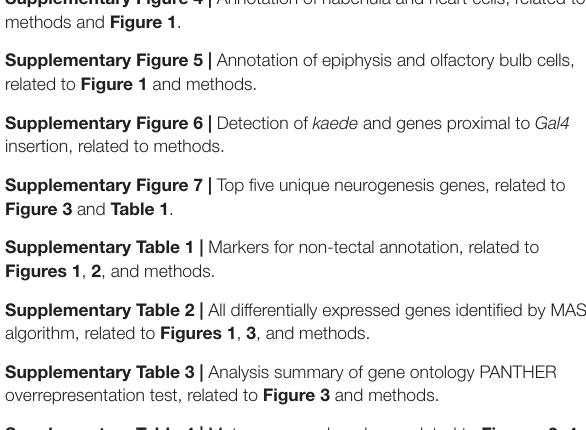
Supplementary Figure 1 | Sorting of kaede + cells for single-cell RNA sequencing, related to methods. Supplementary Figure 2 | Quality control for cell cycle regression, related to methods. Supplementary Figure 3 | Quality control check for batch effect, related to methods. Supplementary Figure 4 | Annotation of habenula and heart cells, related to methods and Figure 1 . Supplementary Figure 5 | Annotation of epiphysis and olfactory bulb cells, related to Figure 1 and methods. Supplementary Figure 6 | Detection of kaede and genes proximal to Gal4 insertion, related to methods. Supplementary Figure 7 | Top five unique neurogenesis genes, related to Figure 3 and Table 1 . Supplementary Table 1 | Markers for non-tectal annotation, related to Figures 1 , 2 , and methods. Supplementary Table 2 | All differentially expressed genes identified by MAST algorithm, related to Figures 1 , 3 , and methods. Supplementary Table 3 | Analysis summary of gene ontology PANTHER overrepresentation test, related to Figure 3 and methods. Supplementary Table 4 | Mature neuronal markers, related to Figures 3 , 4 , and methods. Supplementary Table 5 | Glial markers, related to Figure 3 and methods. Supplementary Table 6 | Genes associated with “neurogenesis” gene ontology term, related to Figure 3 and Table 1 . Supplementary Table 7 | Pre- and postsynaptic neurotransmitter markers, related to Figure 4 and Table 1 , and methods. Supplementary Table 8 | SFARI category 1–2 ASD genes and reviewed UniProt transcription factors, related to Figures 5 , 6 , and